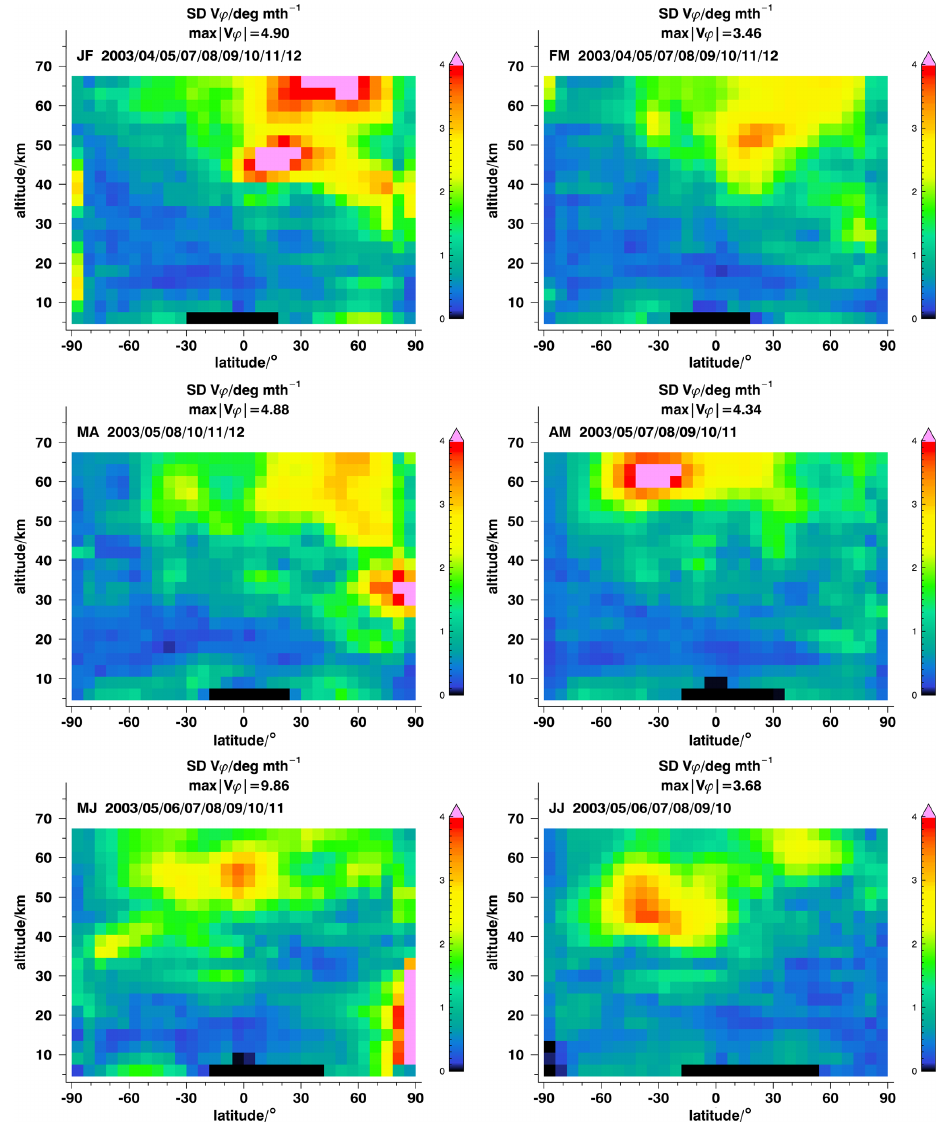
Figure 5. Interannual variability of the middle atmospheric meridional effective velocities in terms of sample standard deviations from January–February (top left, JF) to June–July (bottom right,